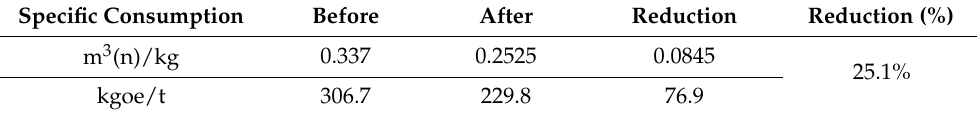
Table 15. Energy indicator of specific consumption before and after implementation of the measures. Specific Consumption